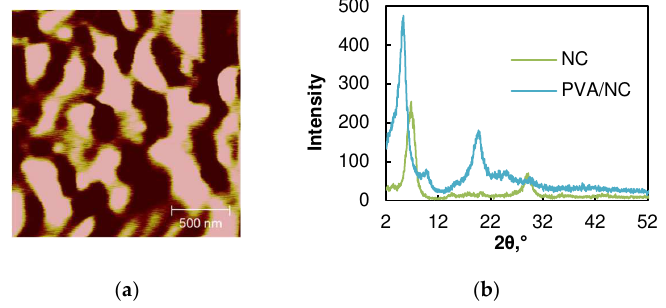
Figure 4. The AFM image ( a ) and XRD ( b ) of crosslinked PVA/NC